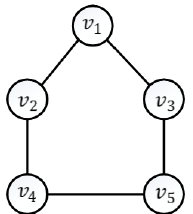
Figure 1. A graph of Example